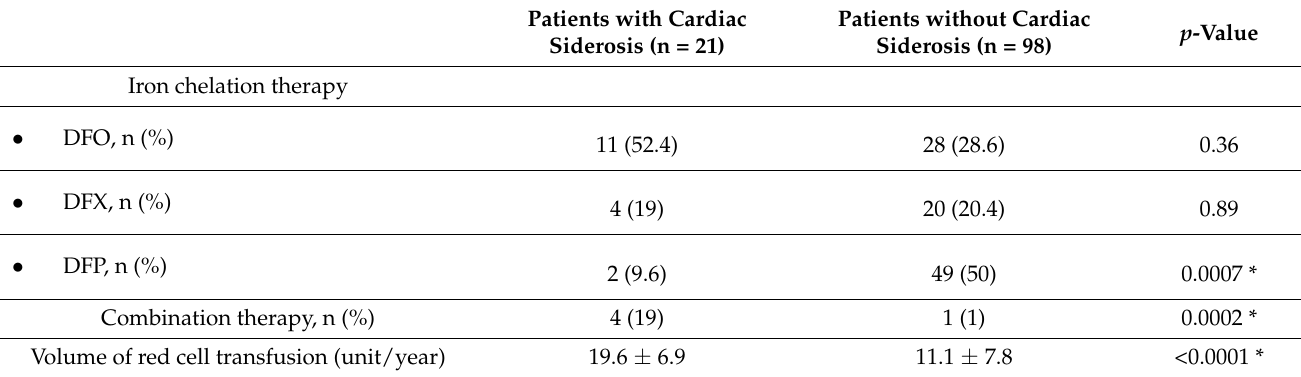
Patients with Cardiac Patients without Cardiac p -Value Siderosis (n = 21) Siderosis (n = 98)